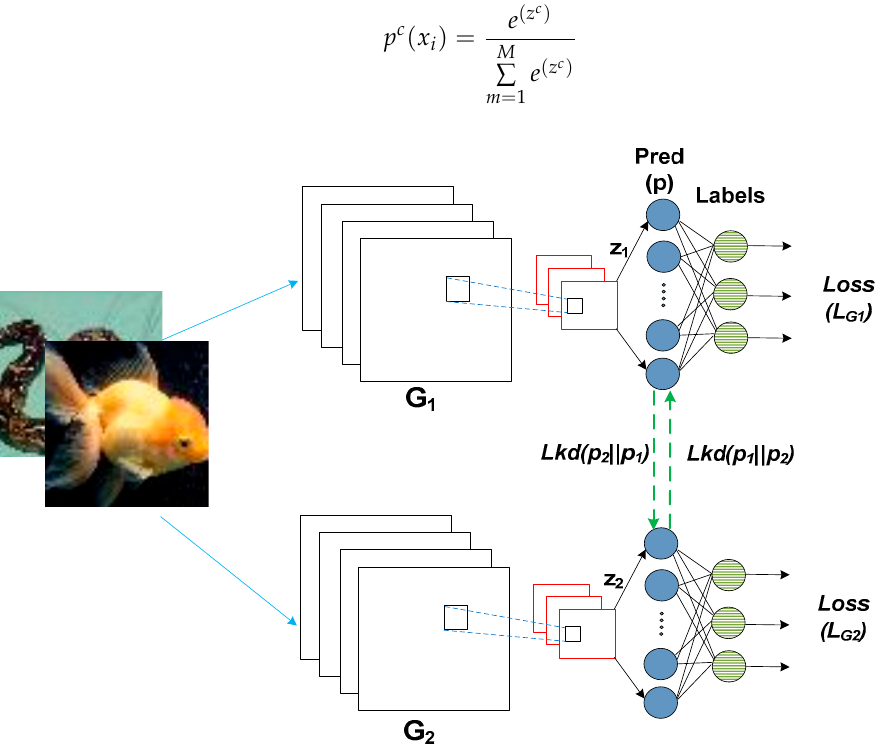
Figure 1. Deep mutual learning (DML) diagram [11] that the network G 1 and G 2 trained simultane- ously together, and using a KLD ‐ based.